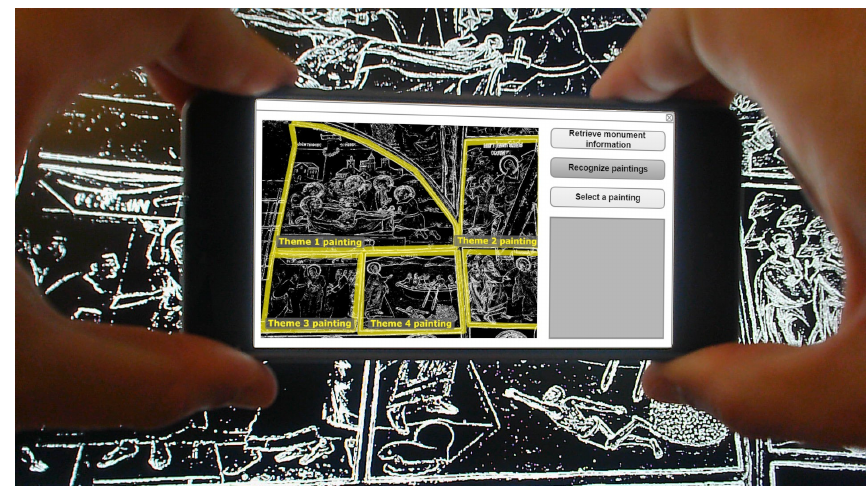
Figure 5. Outer UI Layer demonstration.